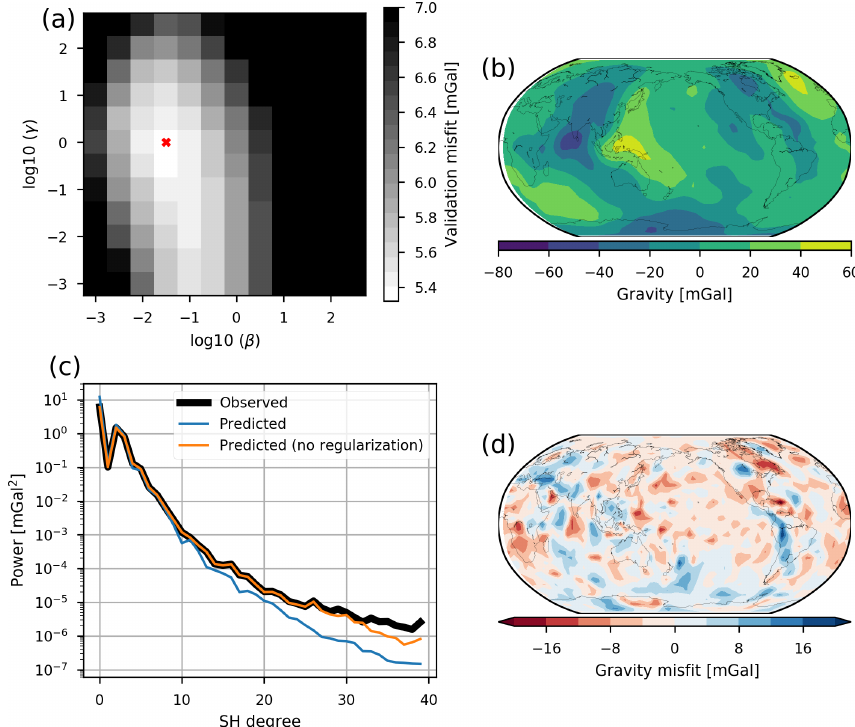
Figure 4. Results of the inversion using the isostatic residual. (a) Validation misfit as a function of regularization parameter β . (b) Predicted field of the inversion results. (c) Spectral comparison of the input and predicted data. (d) Difference between input and predicted data.